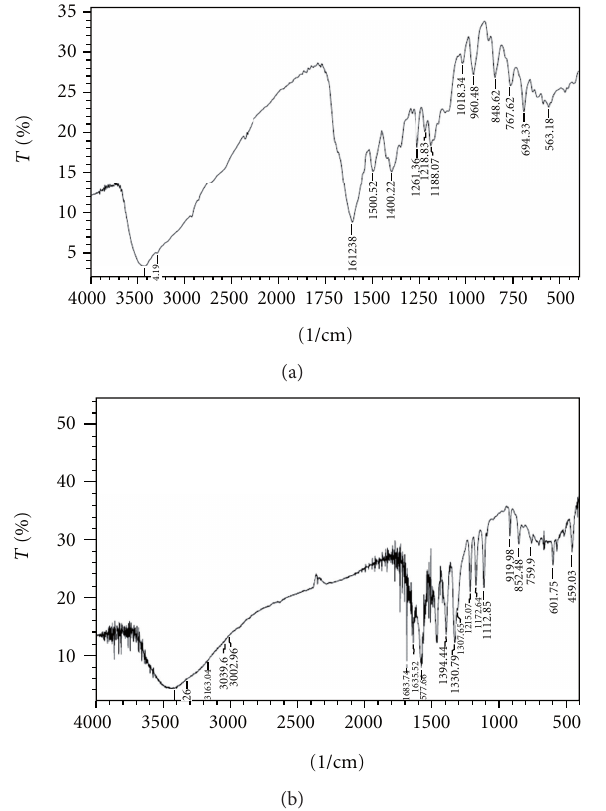
F 4: F�I� spectra of (a) 2,�-dichloro�uorescien hydrazide, (b) 2,�-dichloro�uorescien.